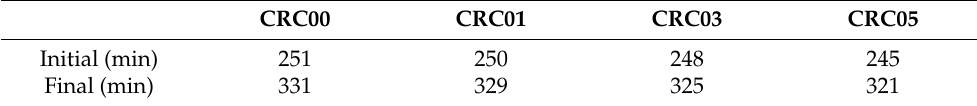
Figure 5. Test method for autogenous shrinkage measurement: ( a ) Diagram of test setup; ( b ) The overview of autogenous shrinkage measurement. Table 3. Setting times of CNT-reinforced cement composites.